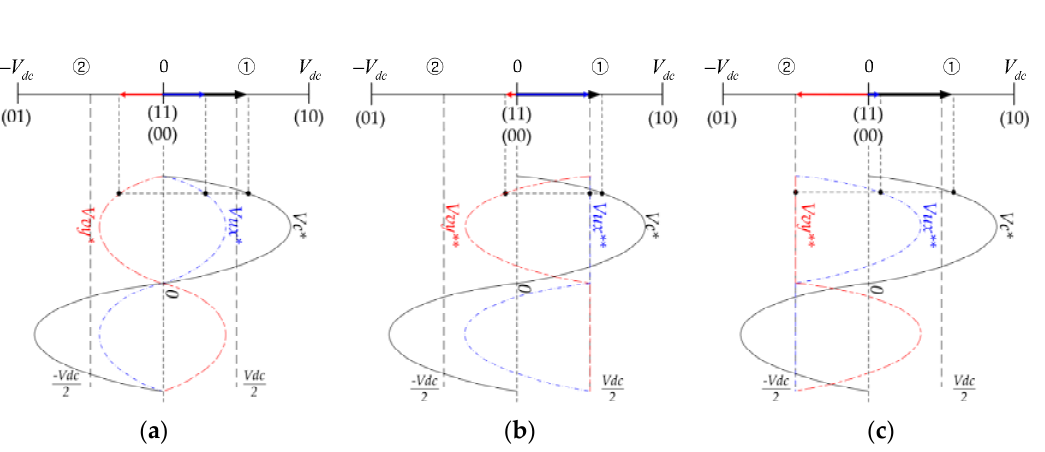
Figure 2. Control block diagram of conventional PWM converter using instantaneous current controller including phase ‐ locked loop (PLL), voltage controller, and PWM generator.